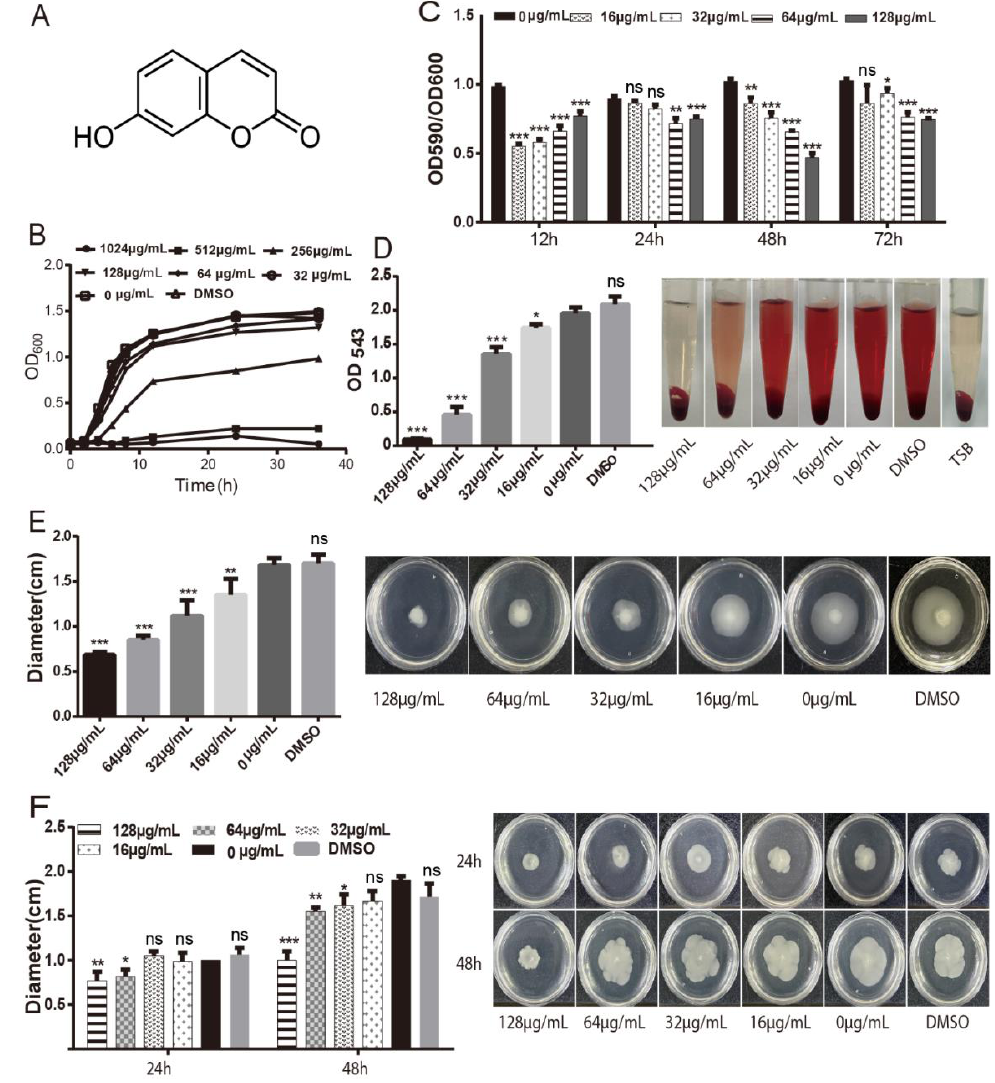
Figure 1. Effect of umbelliferone on the virulence of A. hydrophila : ( A ) structure of umbelliferone; ( B ) growth curve of A. hydrophila ; ( C ) biofilm formation of A. hydrophila was detected by the crystal violet staining method; ( D ) effect of umbelliferone on hemolysis activity of A. hydrophila ; ( E ) effect of umbelliferone on swimming motility of A. hydrophila ; ( F ) effect of umbelliferone on swarming motility of A. hydrophila ; ***, p < 0.001; **, p < 0.01, *, p < 0.05; ns, not significant, compared with the control (0 µ